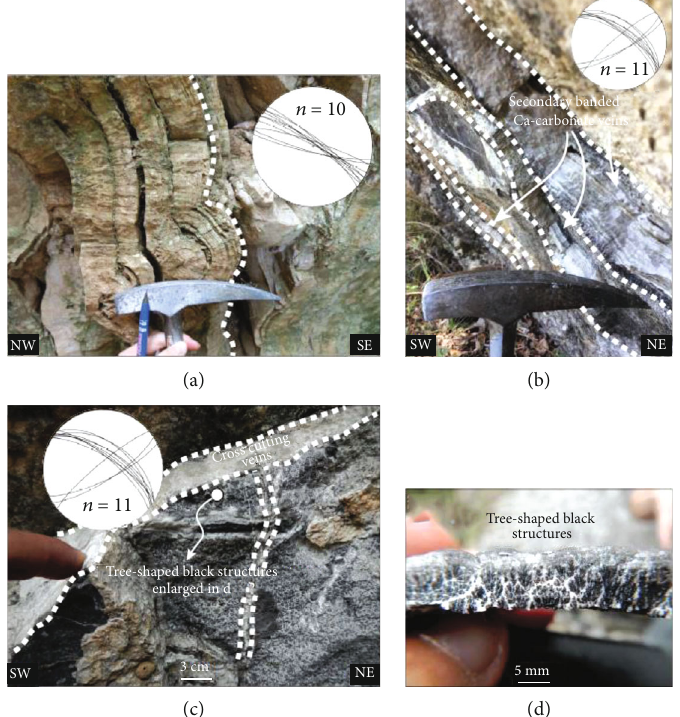
Figure 7: (a) Detail of banded Ca-carbonate vein showing a botryoid shape. (b) Detail of banded Ca-carbonate veins a ff ecting the upper part of the fi ssure ridge. (c) Detail of NW-trending banded Ca-carbonate vein intersected by NE-trending banded vein. (d) Detail of black tree- shaped structures a ff ecting the external band of PAM1